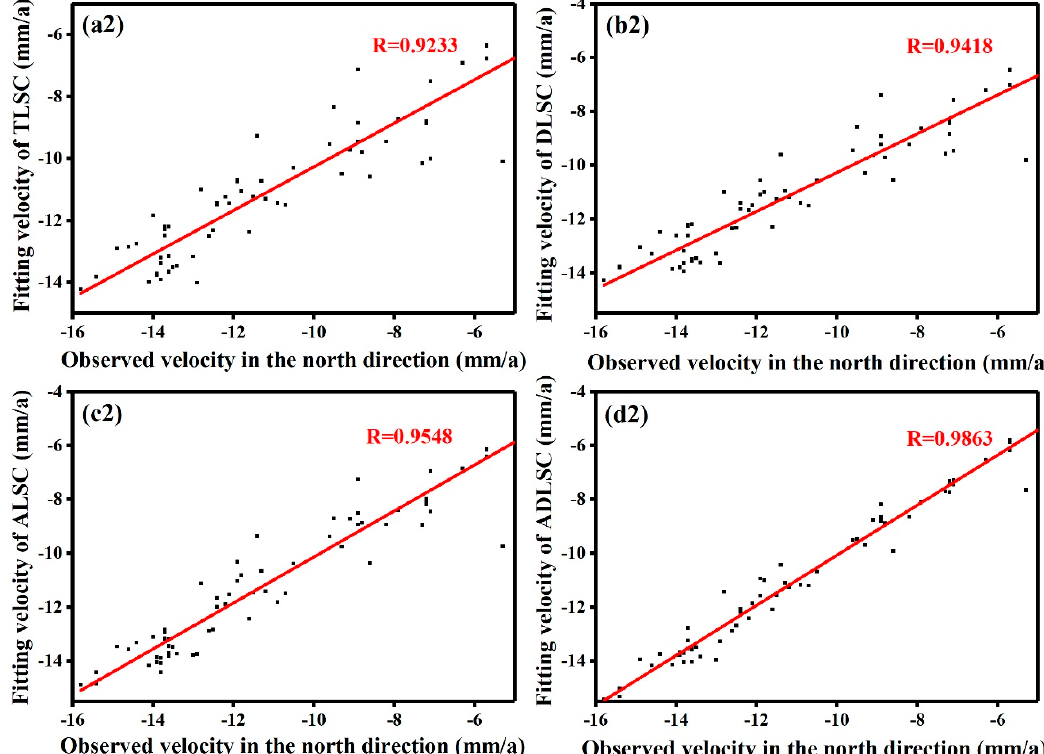
Figure 5. Correlation analysis between the fitting and observed velocity in the east ( a1 , b1 , c1 , and d1 ) and north directions ( a2 , b2 , c2 , and d2 ).